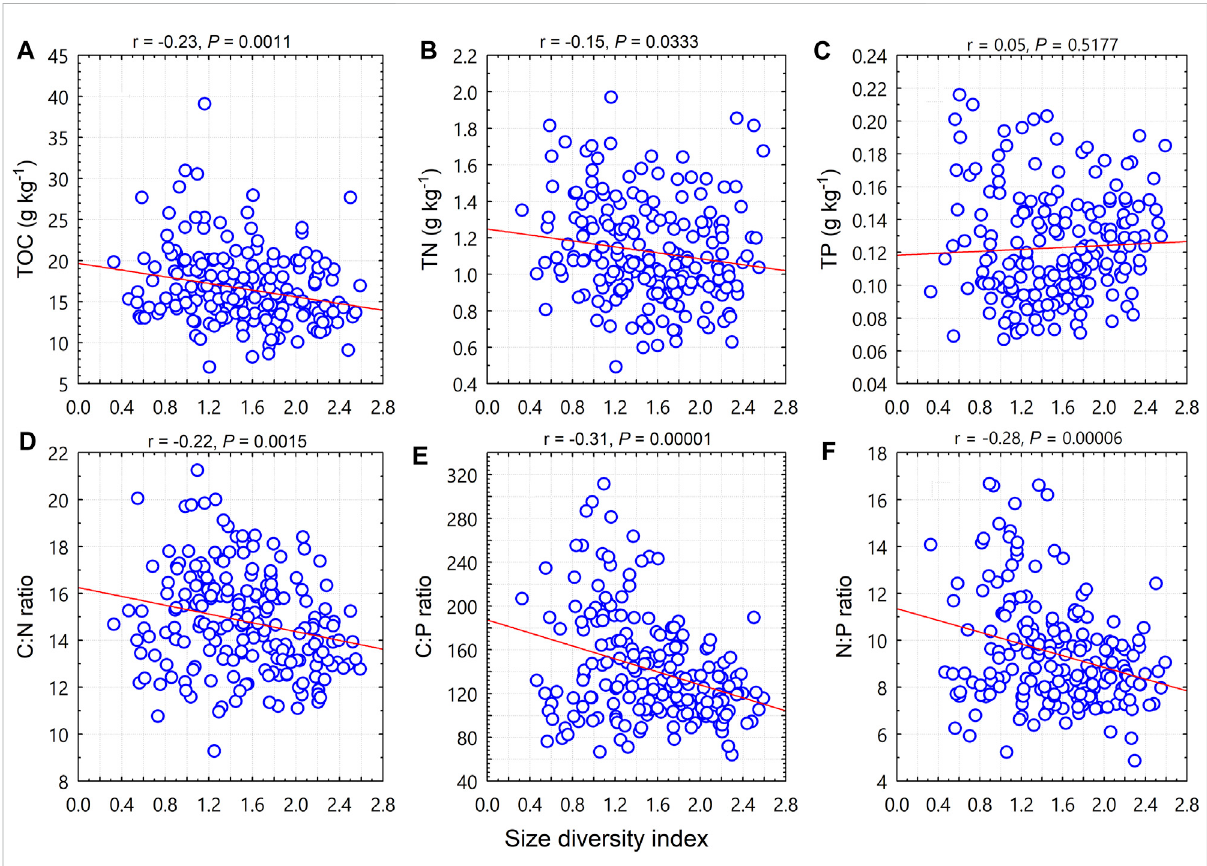
FIGURE 3 Relationshipsbetweenwoodyplantsizediversityindexandsoiltotalorganiccarbon(TOC),totalnitrogen(TN),totalphosphorus(TP),andC:N:P stoichiometric